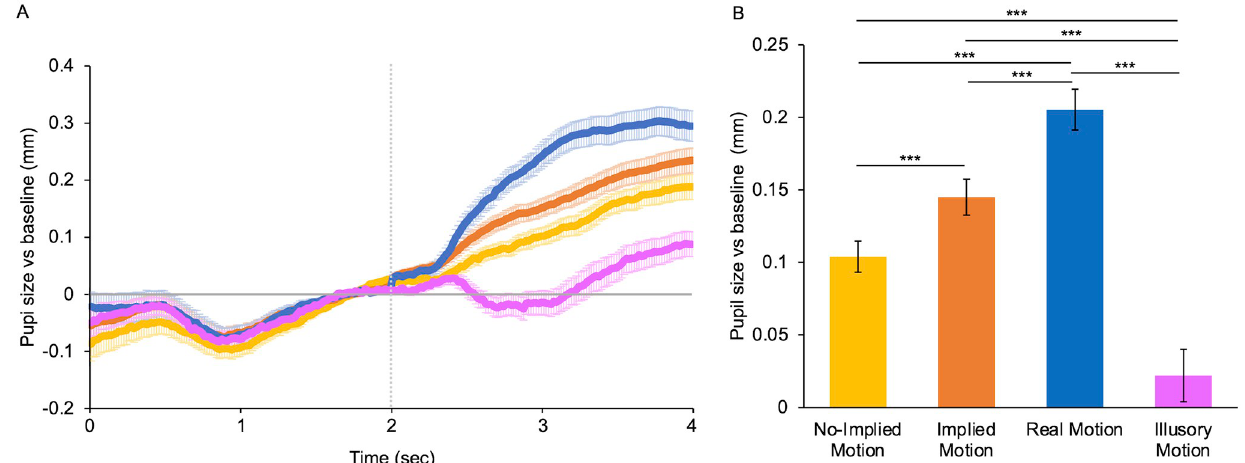
Fig 2. Mean pupillary response for different types of motion. (A) Baseline-corrected pupil size for different motion categories plotted as a function of time from trial onset. The horizontal line represents the baseline: data over the zero-line represent pupil dilation whereas data under the line represent pupil constriction. The vertical line indicates the stimulus onset. Error bars are SE. (B) Mean pupillary diameter for different categories of motion during stimulus presentation. Categories include both objects/animals’ and humans’ subjects. Yellow: photos with no implied motion (No-IM); orange: photos with implied motion ( freezed and enhanced IM); blue: movies with moving subjects (real motion); purple: motion illusions (Illusory motion). Error bars are SE. Asterisks mark statistically significant pairwise comparisons across image categories: ��� p < 0.001.